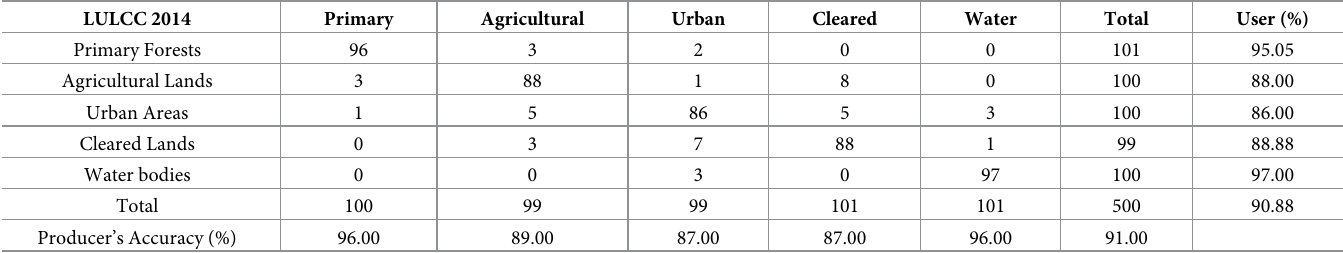
Table 3. Confusion matrix of 2014 land cover